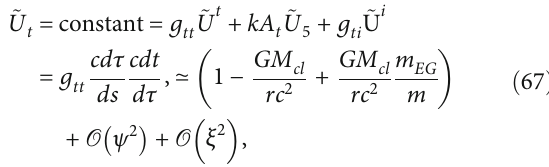
~ ≫ ξ − 1 , but is omitted for clarity. ξ c 2 , is large for U 2 E 5